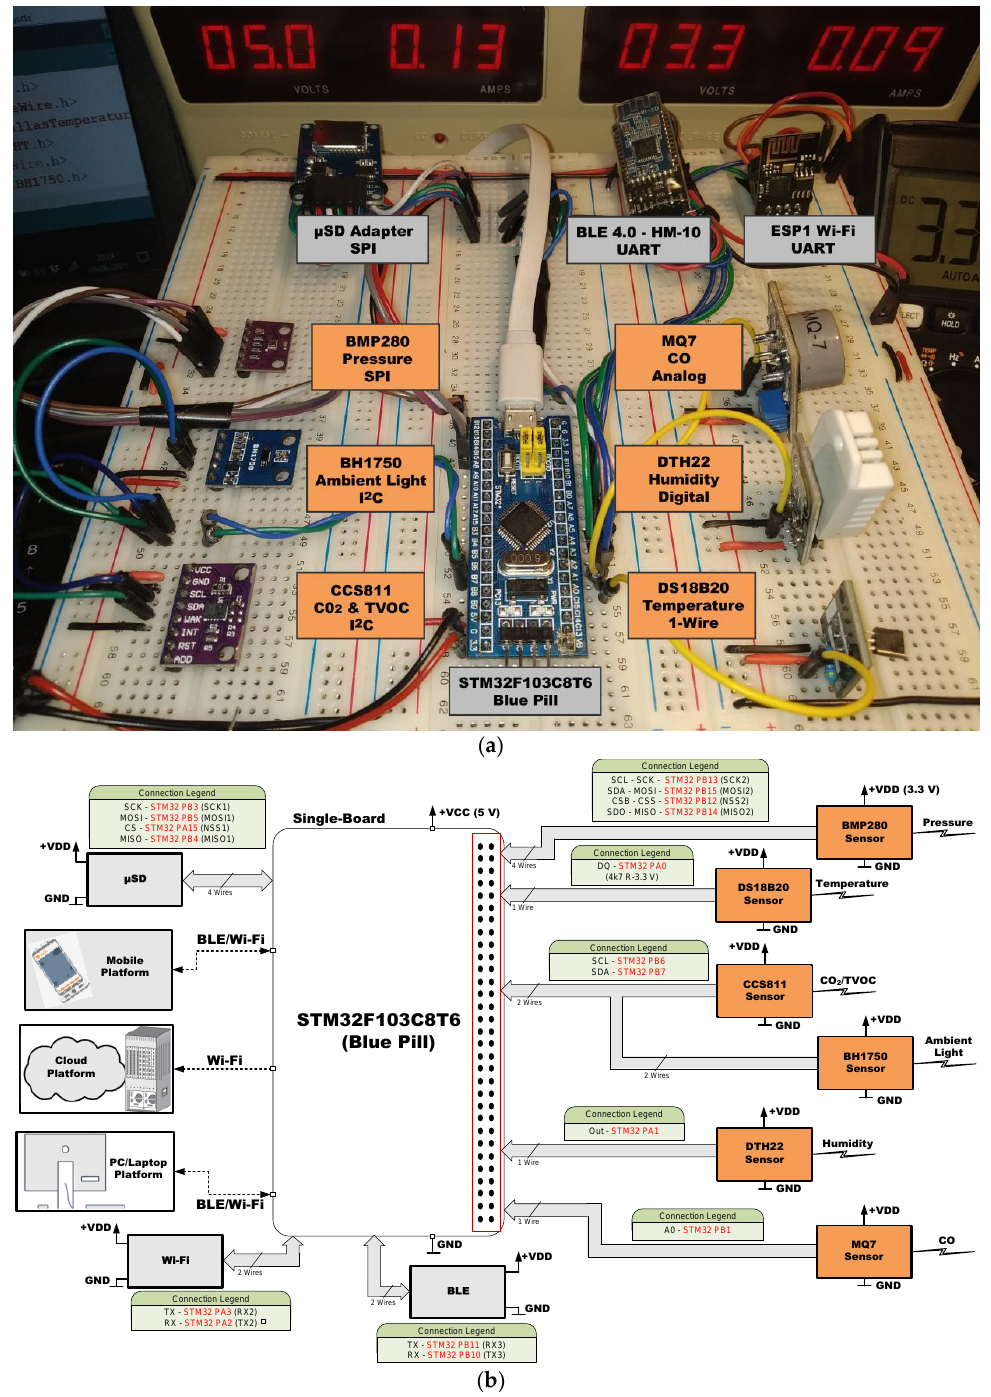
Figure 10. SBM STM32F103C8T6 (Blue Pill) in experimental framework ( a ) and hardware connections ( b ) [150].